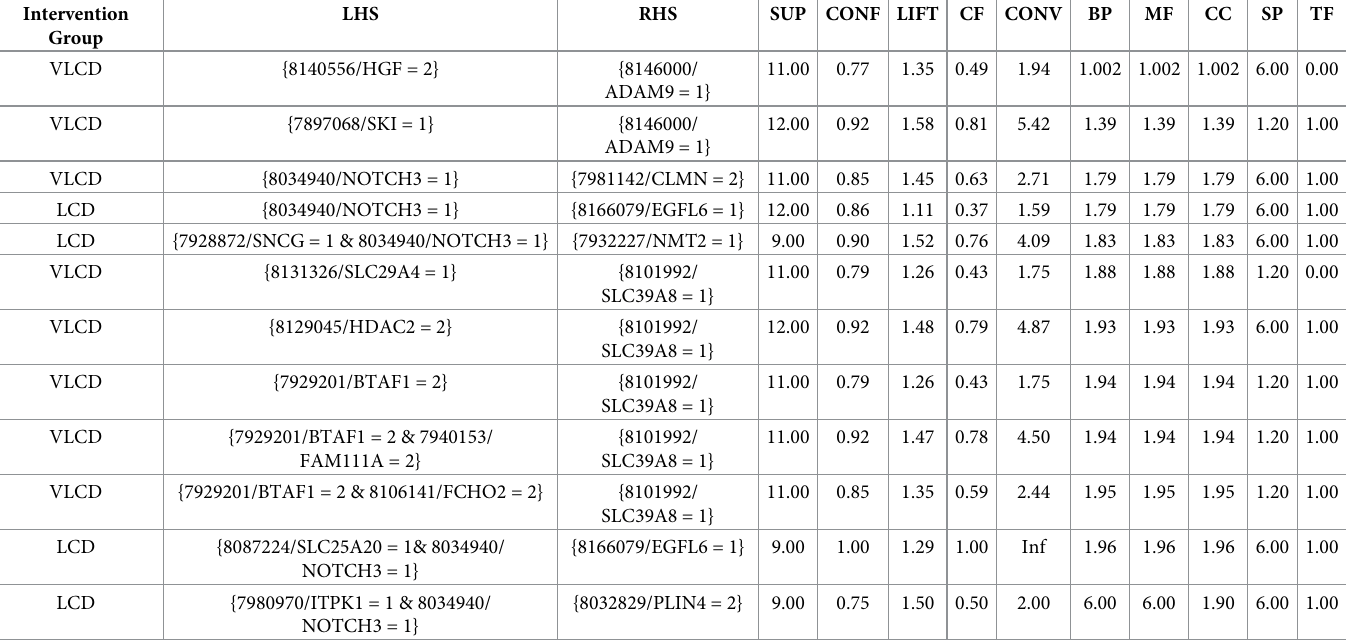
Table 3. Subset of biologically meaningful extracted sequential rules in the whole GSE77962 dataset (LCD and VLCD groups). Intervention